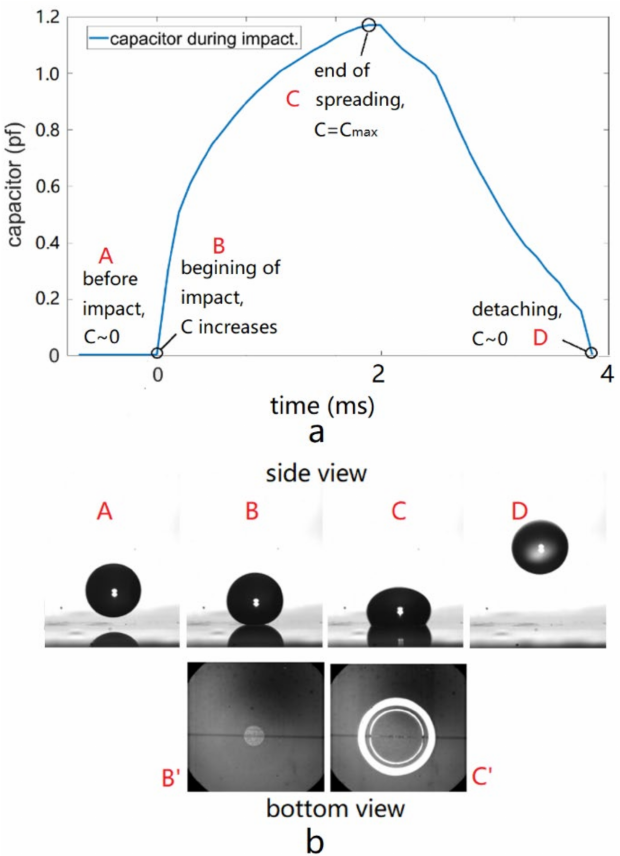
Figure 5. Evolution of the droplet capacitance value during the impacting process ( a ) and the corresponding droplet images at the distinct turning point ( b ). A, B, C and D indicate that the droplet levitates in the air, impacts the substrate, spreads to maximum base radius and leaves the substrate. Note Figure 5b also shows the bottom-view images corresponding to B and